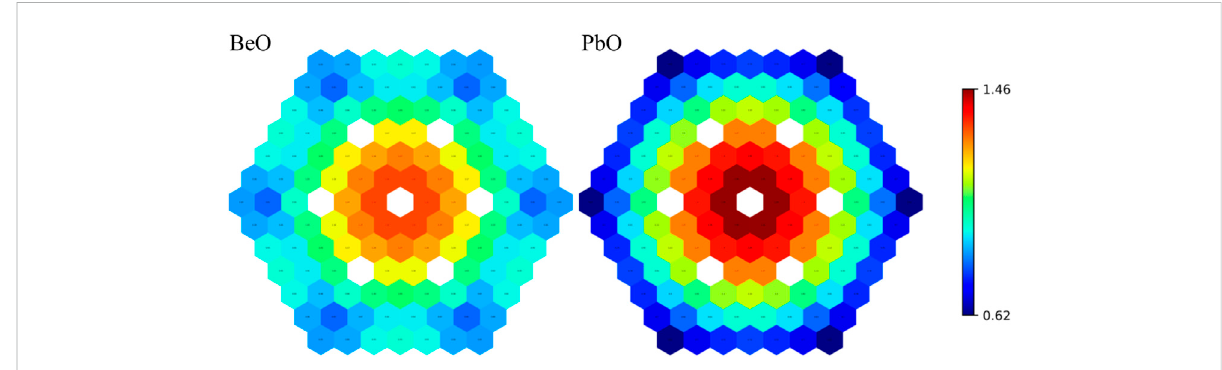
FIGURE 8 Assembly power distribution results on the beginning of life of the re fl ector material analysis.